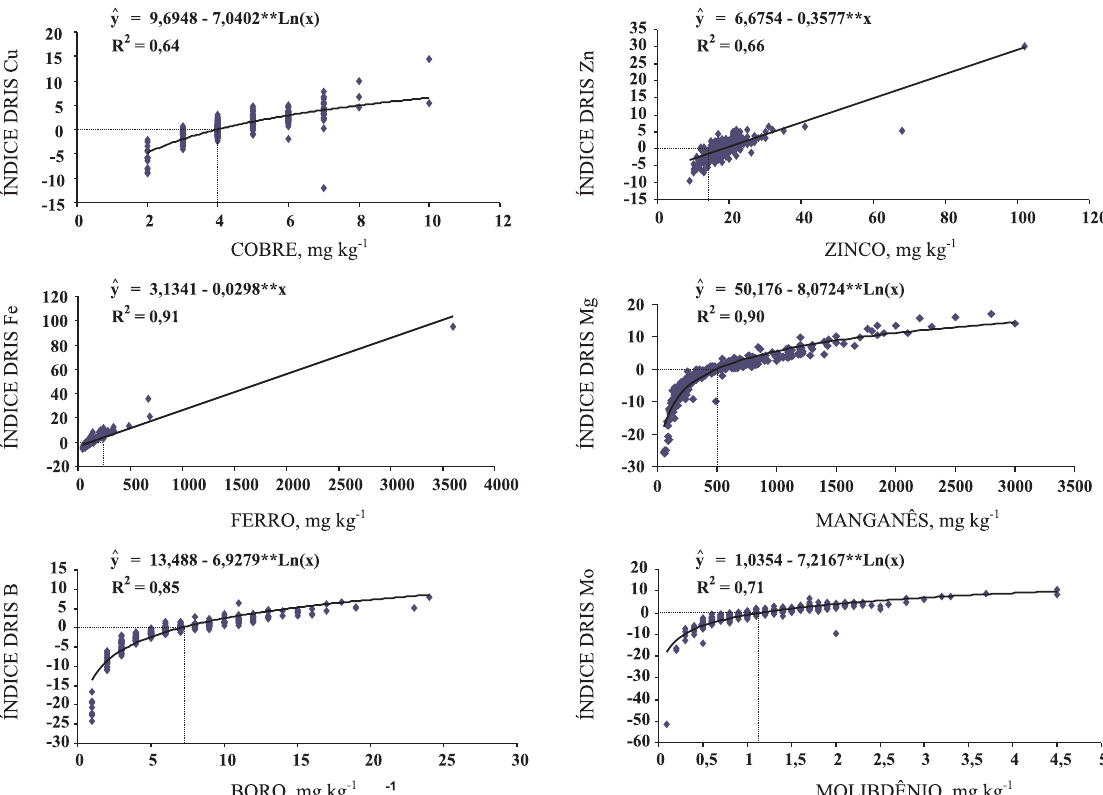
Figura 3. Relação entre os índices DRIS e a concentração de micronutrientes nas folhas de lavouras de arroz irrigado por inundação do Rio Grande do Sul, safra